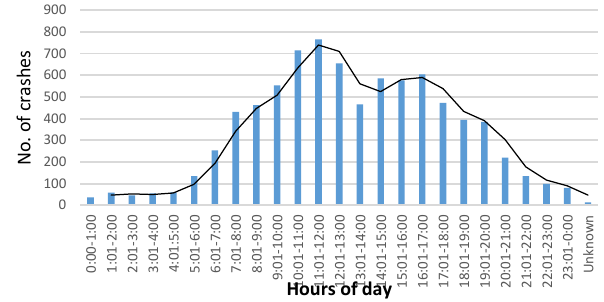
Figure 1: Variation of heavy vehicle crashes by hours of day